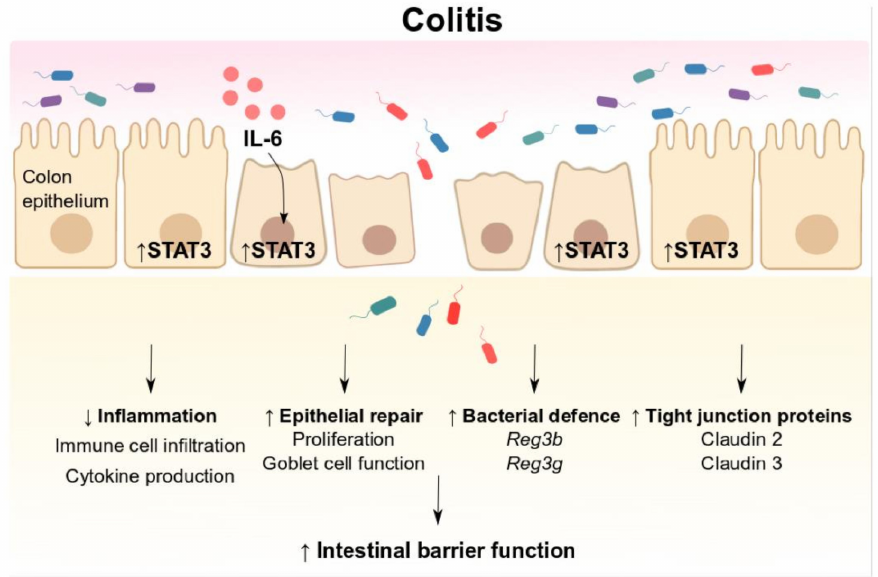
Figure 6. Schematic overview of IL-6ST/gp130/STAT3-mediated effects on intestinal barrier function during colitis. IL-6ST/gp130/STAT3 signalling is induced in the colonic epithelium during the development of colitis. STAT3 is central for regulating intestinal barrier function through several mechanisms: (i) STAT3 suppresses inflammation by regulating immune cell infiltration and cytokine production; (ii) promoting epithelial repair by enhancing proliferation and maintaining goblet cell function; (iii) enhancing bacterial defence through induction of the antimicrobial genes Reg3b and Reg3g ; and (iv) regulating colonic permeability through the tight junction proteins, claudin 2 and claudin 3. IL: interleukin; STAT3: signal transducer and activator of transcription factor-3. Reg3 : regenerating islet-derived protein-3.